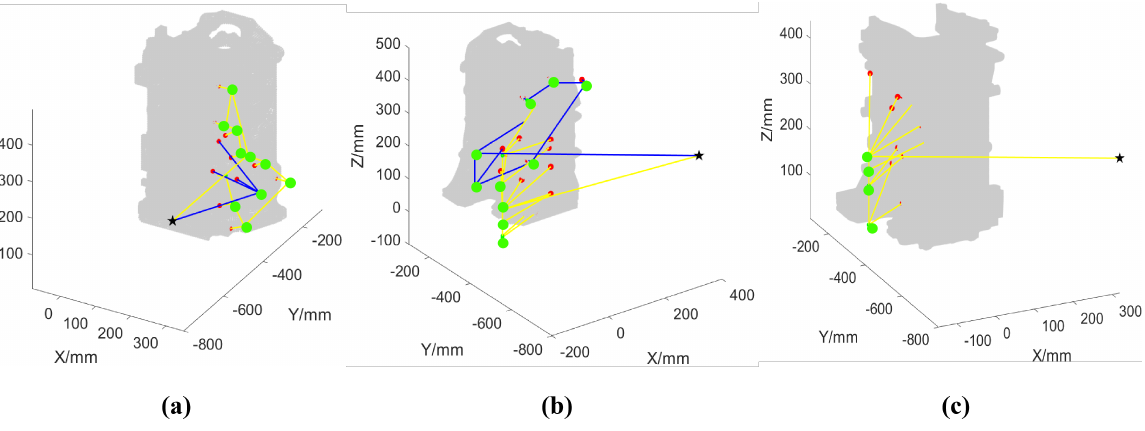
Figure 15. Inspection path diagram based on RRT-MRNC algorithm. ( a ) Collision-free path for groups 1–2, in which yellow line represents the path of S 1 and blue line represents the path of S 2 . ( b ) Collision-free path for groups 3–4, in which yellow line represents the path of S 3 and blue line represents the path of S 4 . ( c ) Collision-free path for groups